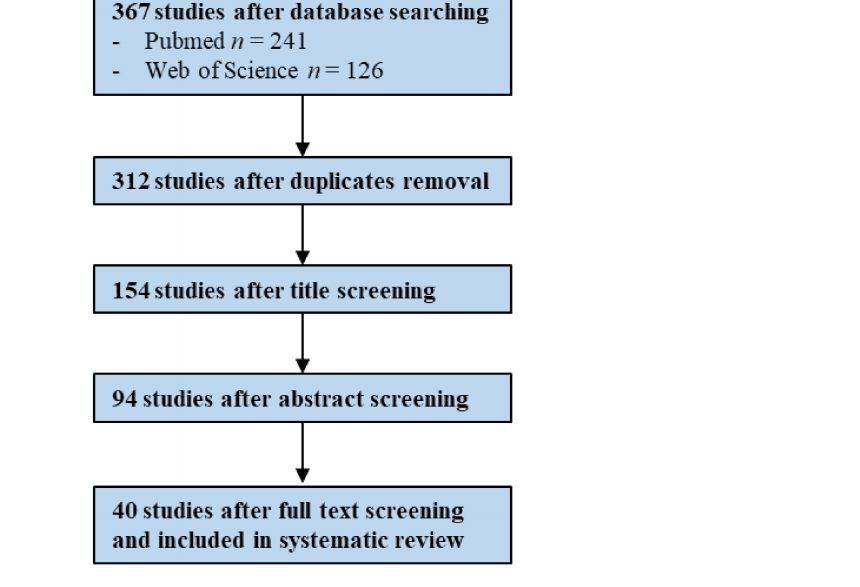
Figure 1. Flowchart illustrating the study screening process—BSIs (Bloodstream